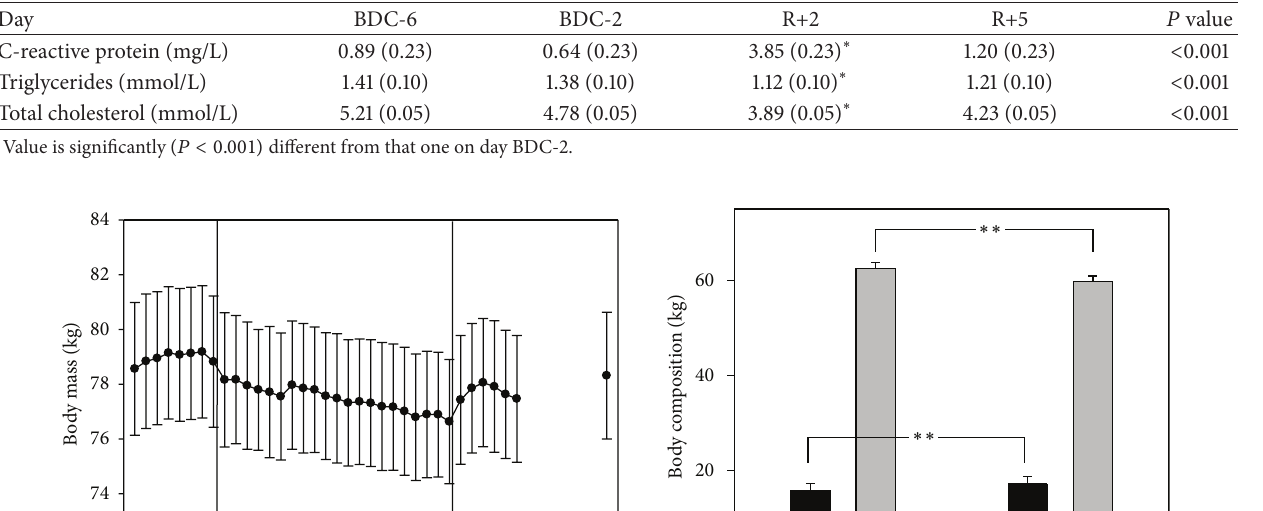
Table 2: Mean values of C-reactive protein, triglycerides, and total cholesterol.